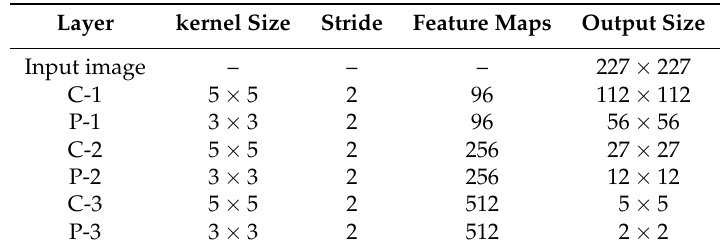
Table 1. Information about each convolutional neural networks (CNNs) layer. Layer kernel Size Stride Feature Maps